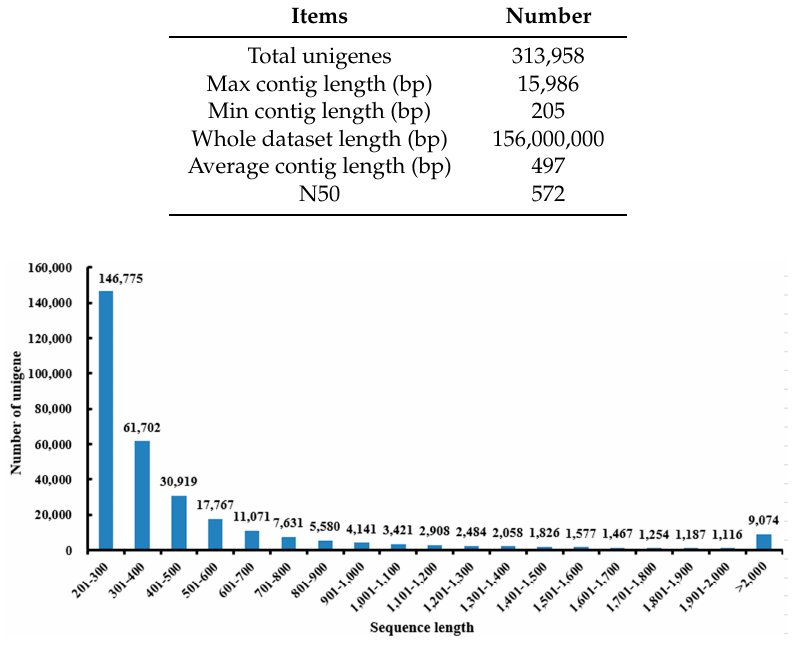
Figure 1. The length distribution of the assembled unigenes.